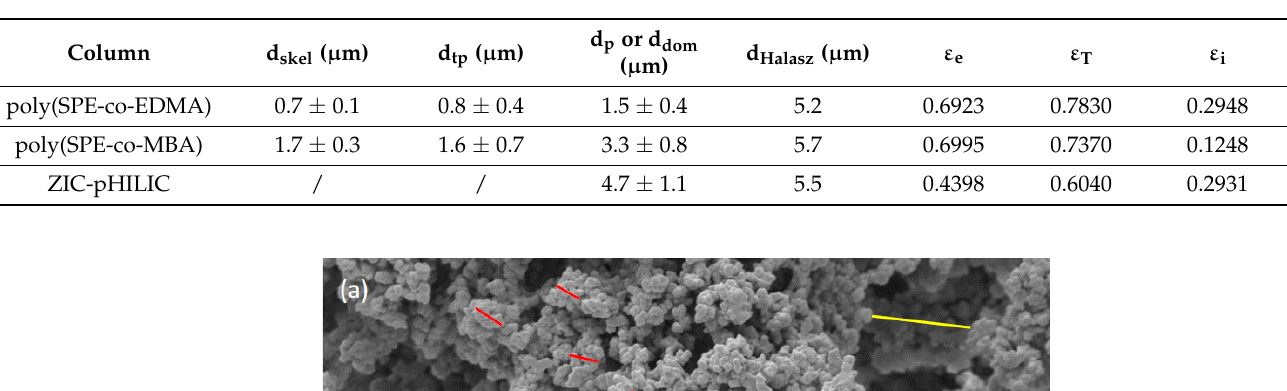
Table 1. Structural characteristics (d glob , d tp , d dom and d Halasz ) and column porosities of the columns evaluated in this work. The reported sizes show the average values of at least 100 independent measurements and their standard deviations.